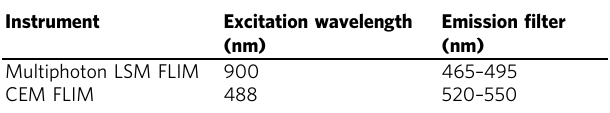
Table 1 Excitation and emission fi lters used